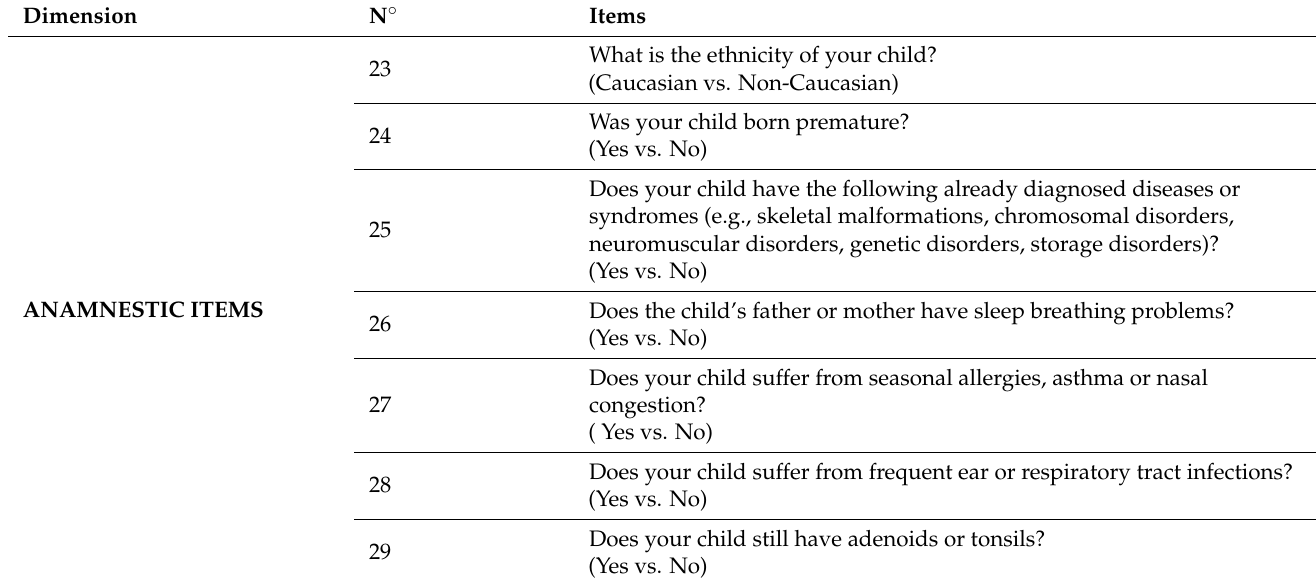
Table 1. Items added to the Paediatric Sleep Questionnaire (PSQ) and considered for paediatric obstructive sleep apnoea syndrome (OSAS) screening.